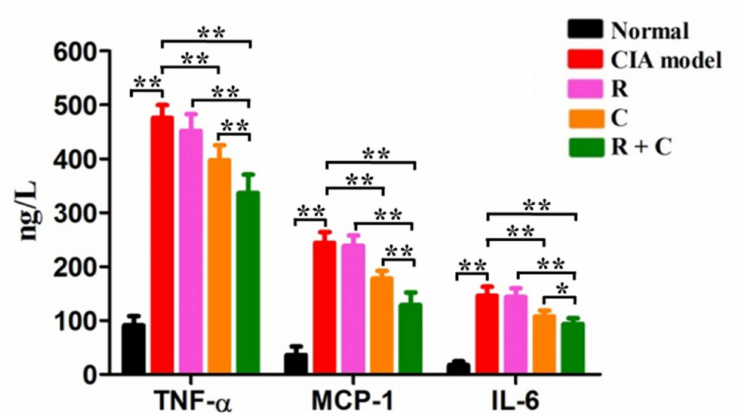
Figure 5. The effects of rosmanol (R), carnosol (C), and their combination (R + C) on the production of TNF- α , MCP-1, and IL-6. The serum levels of TNF- α , MCP-1, and IL-6 of each group were determined by ELISA on day 42. Data are presented as the means ± SD ( n = 6). The significance of differences was analyzed by unpaired t -test. Note: * p < 0.05; ** p <